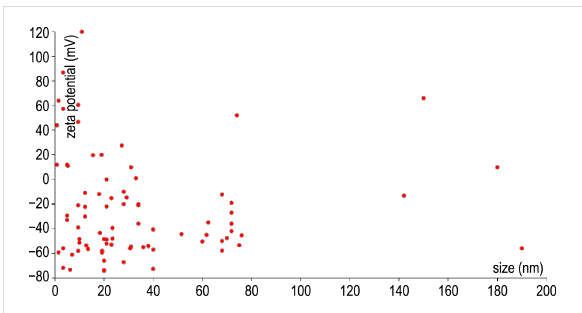
Figure 18: Scatter plot of nanomaterial zeta potentials against the nanomaterial sizes, also created with d3.js and ambit.js.